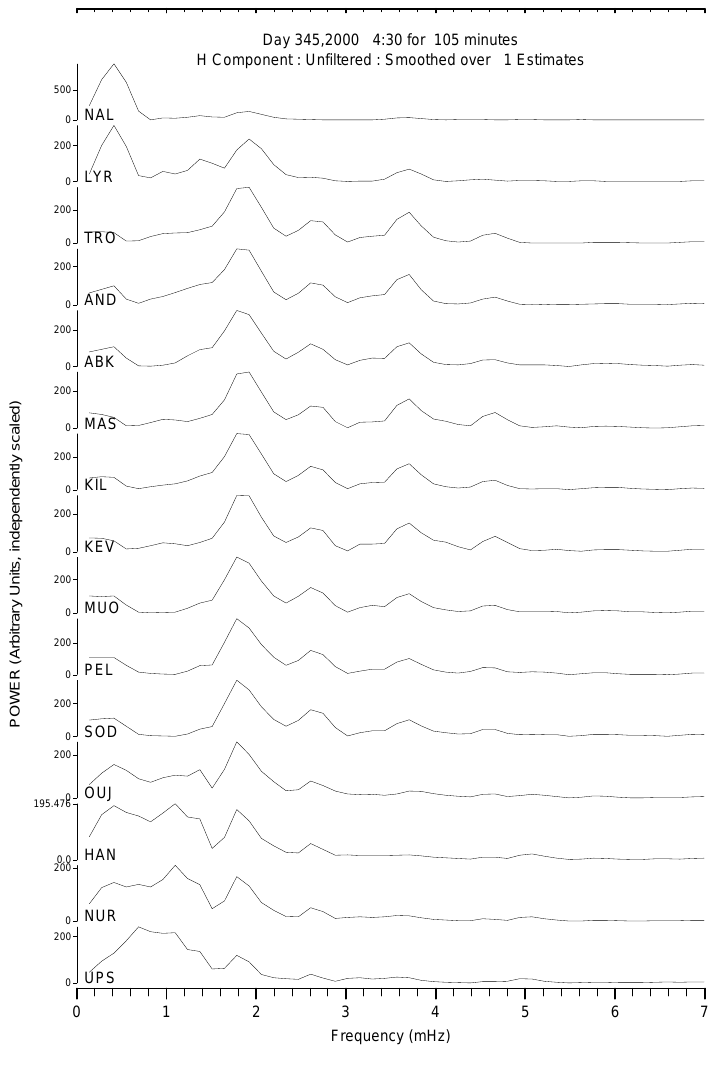
Fig. 20. Unfiltered H -component power spectra from selected IMAGE magnetometer stations between 04:30– 05:45UT. Clear latitude independent spectral peaks are apparent at around 1.9, 2.7, 3.7 and